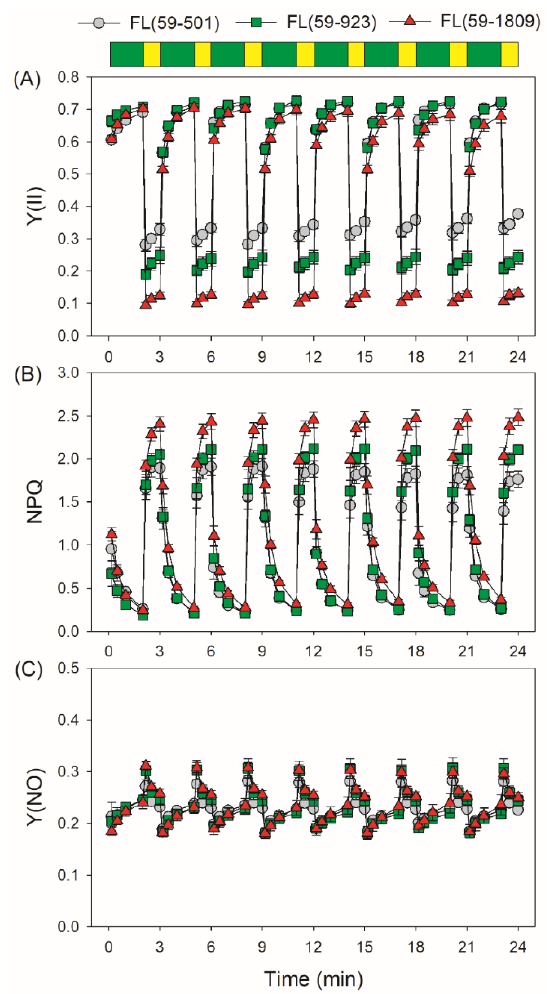
Figure 2. Changes in the PSII parameters under different fluctuating light conditions. After light adaptation at 1455 µ mol photons m − 2 s − 1 for 5 min to activate photosynthetic electron sinks, leaves were exposed to fluctuating light alternating between low (59 µ mol photons m − 2 s − 1 , 2 min) and high light (501, 923 or 1809 µ mol photons m − 2 s − 1 , 1 min). The PSII parameters were recorded in low light (10 s, 30 s, 60 s and 120 s) and high light (10 s, 30 s and 60 s). ( A ) Y(II), the effective quantum yield of PSII photochemistry; ( B ) NPQ, non-photochemical quenching in PSII; and ( C ) Y(NO), the quantum yield of non-regulatory energy dissipation in PSII. Data are shown as the means ± SE ( n = 5). Green bars indicate low light (59 µ mol photons m − 2 s − 1 ); yellow bars indicate high light (501, 923 or 1809 µ mol photons m − 2 s − 1